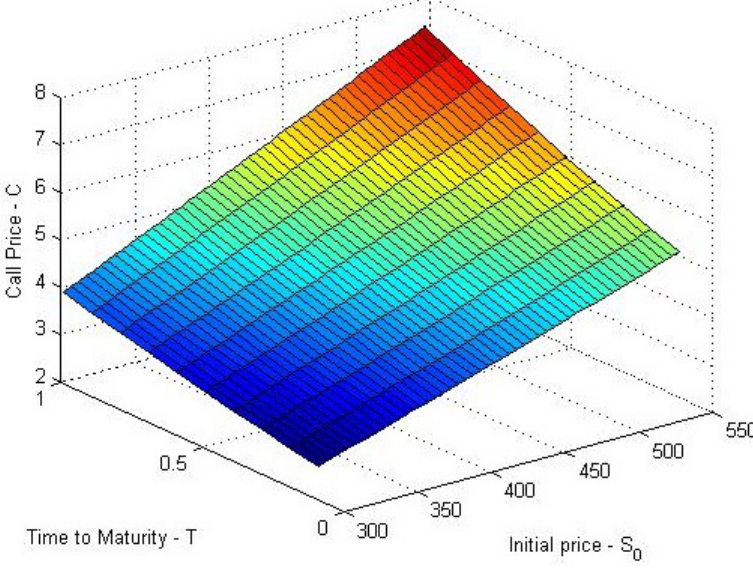
Figure 2. Up-And-Out call with NIG ( α = 6 . 1882 , β = − 3 . 8941 , δ = 0 . 1622 ) with Stock Price S 0 = 450, Strike price K = 150, Barrier B = 350, σ = 0.1812, r = 0.167 and Time to maturity T =